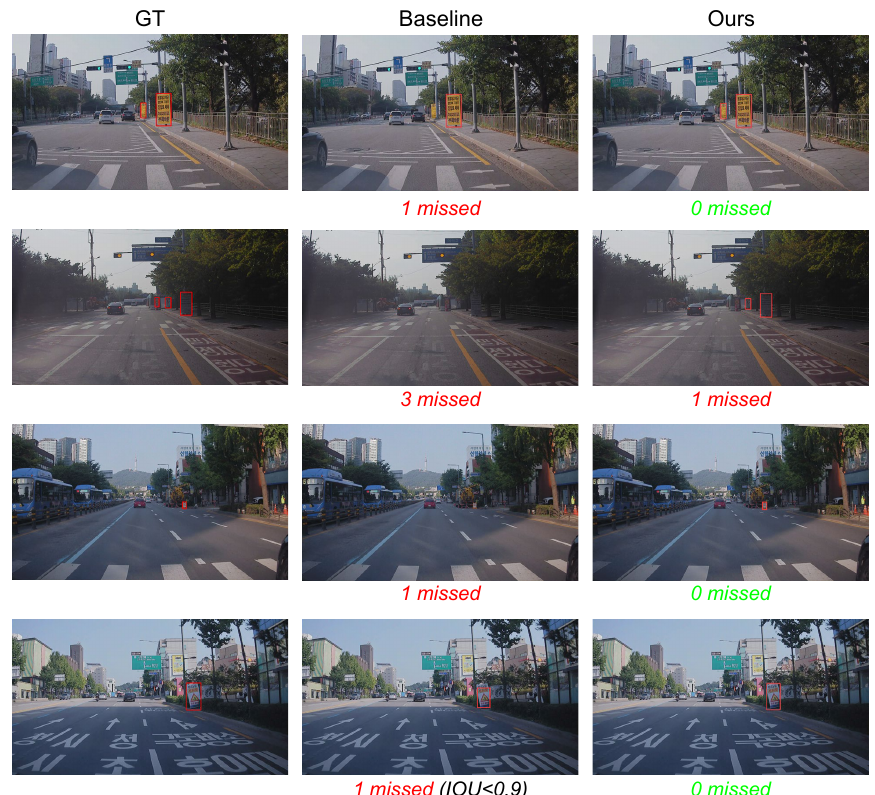
Figure 11. Qualitative results on CSS138 validation set. From left to right, each row shows ground truth (GT), the baseline (naive cut-and-paste), and Ours. For each result on the baseline and ours, we denote the number of missed construction signs.